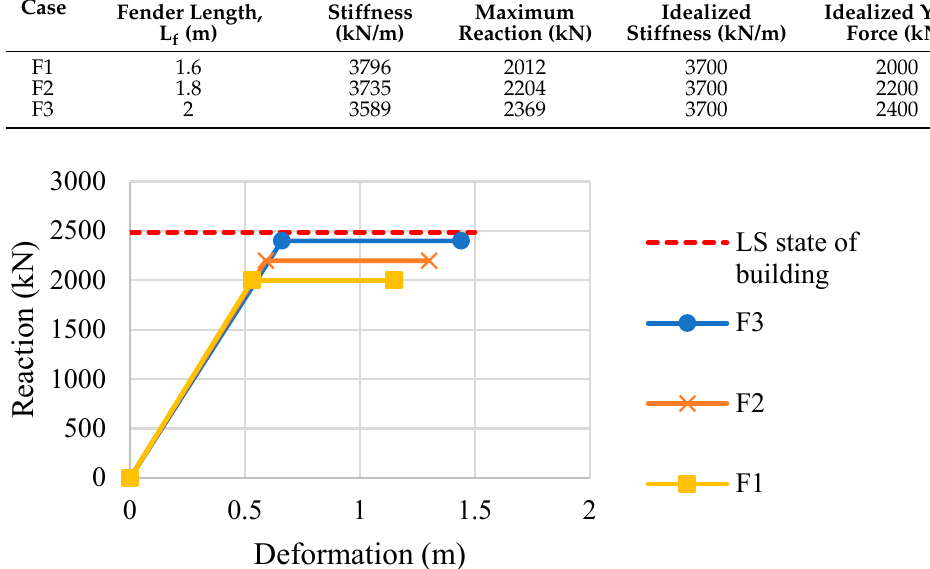
Figure 13. Idealized force–deformation relation of the fenders.